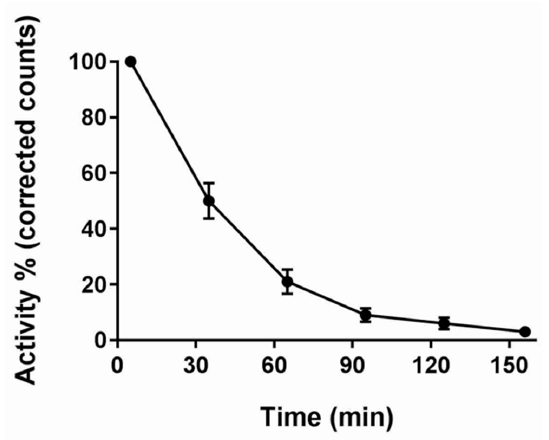
Figure 3. Percentage activity in the stomach region of interest measured with gamma scintigraphy plotted against time after feeding the soup test meal n = 12 participants, data are shown as mean ± SEM. Counts were corrected for background radioactivity and radioisotope decay.